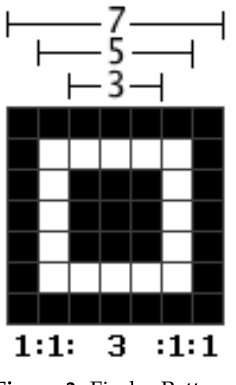
Figure 3. Finder Figure 3. Finder Pattern. Figure 3. Finder Pattern.